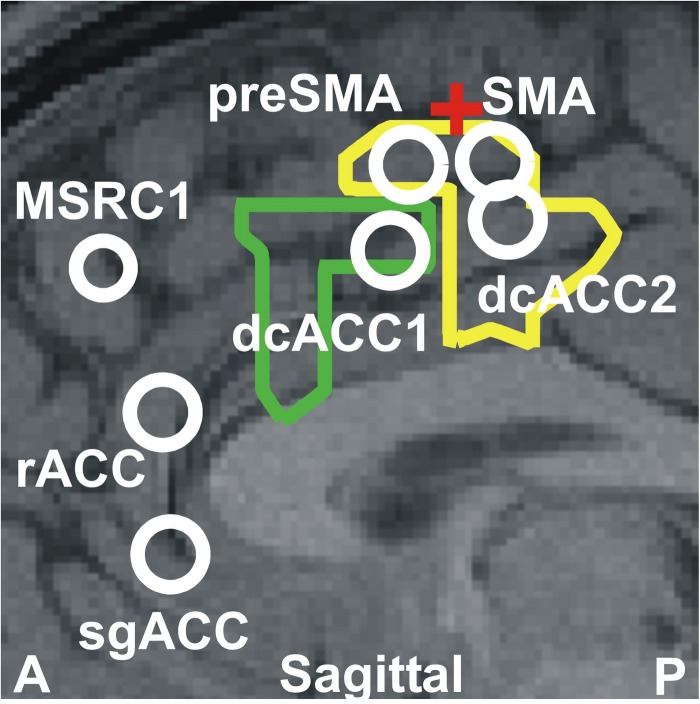
The seven key areas identified in this paper and in our previous studies (Ioannides et al., 2009; Ioannides, 2017); they are the six areas that play a key role in REM2 sleep and the area monotonically increasing its gamma power as sleep progresses from light to deep and finally REM sleep (Ioannides et al., 2009). The areas are displayed onto a mid-sagittal MRI about 2 mm inside the left hemisphere. The area dcACC1 plays a pivotal role in the generation of KCs. Three other areas are identified adjacent to dcACC1. One of these areas lies within dcACC; this area dcACC2 is just caudal to dcACC1 and is related more to spindles but it also plays a role for KCs, especially in the delta band. The area dorsal to dcACC1 is in the pre-SMA and the one rostral to dcACC2 in the SMA. These two areas are activated prominently (with dcACC2) during spindles and seem to make up the generator of the slow spindles. These two premotor areas show modest increases during both KCs and spindles in the theta and alpha bands. The two areas close to rACC seem to play a distinct role. The more dorsal area rACC relates more to spindles. The more ventral area relates to KCs and it is on the subgenual ACC (sgACC), at its more dorsal and ventral part close to the border with rACC. The two outlines showing the modest increase in activity at 4.8 Hz for spindles (yellow) and KCs (green) are also projected on the same MRI slice. The assignment of the two premotor areas to SMA and pre-SMA is made by reference to two earlier works early works for separating Broadman area 6 into SMA and pre-SMA sub-divisions. The first, relates animal studies to early human imaging studies of the areas (Picard and Strick, 2001) and the second is a recent work combining cytoarchitectonic and functional information (Ruan et al., 2018). The red cross marks the location of the rough border of SMA and pre-SMA as defined by the blue cross-hair in Figure 7 of Ruan et al. (2018). The TC of these areas and details of the spectral power changes for each one before and during KCs are given in Table 3.